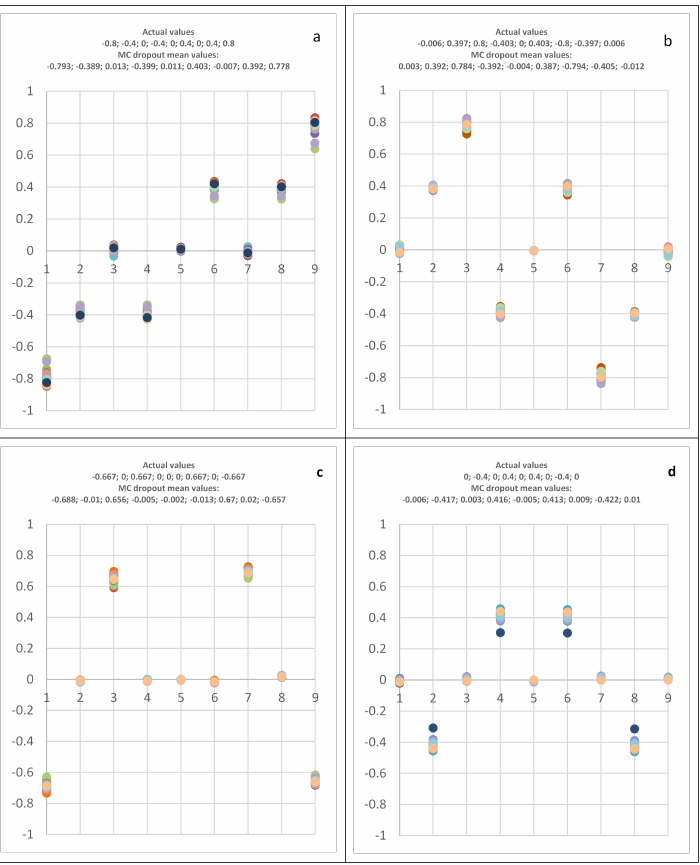
Figure 3. Values dispersion of a representative coarse grid: ( a ) for Basis 2, ( b ) for Basis 3, ( c ) for Basis 4, and ( d ) for Basis